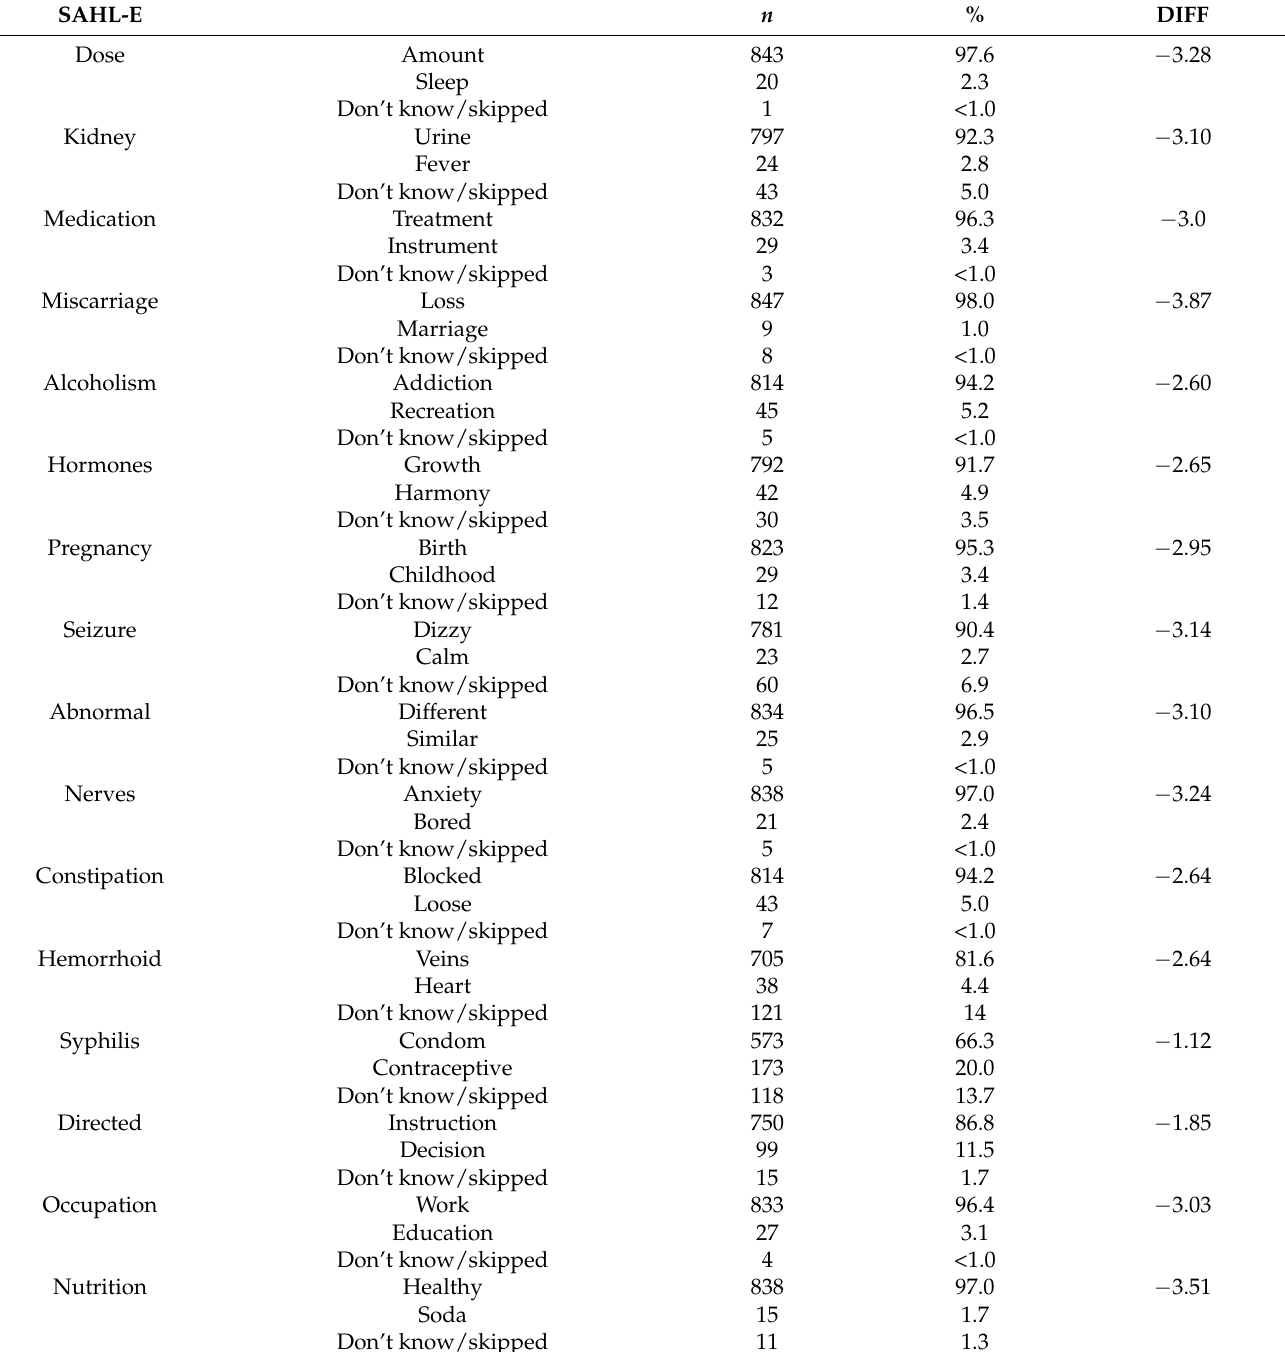
Table 2. List of SAHL and SA-EHL items (left column) and possible responses (correct response, distractor, “Don’t